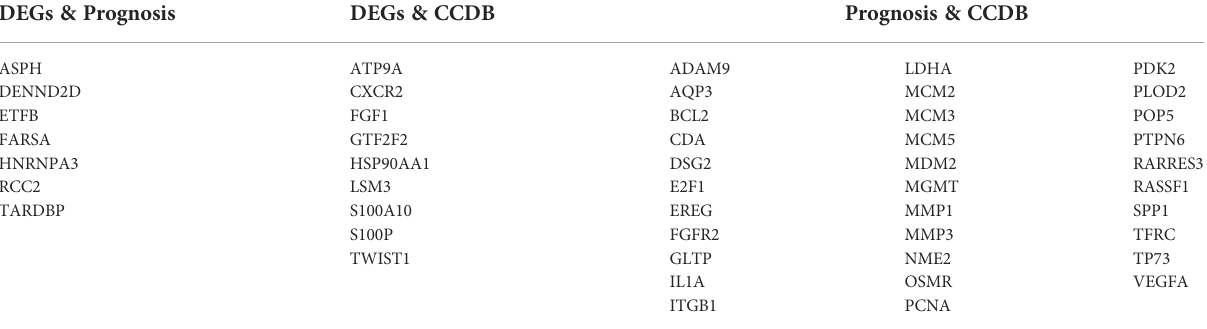
TABLE 2 Genes at the intersection of 3 databases. DEGs & Prognosis